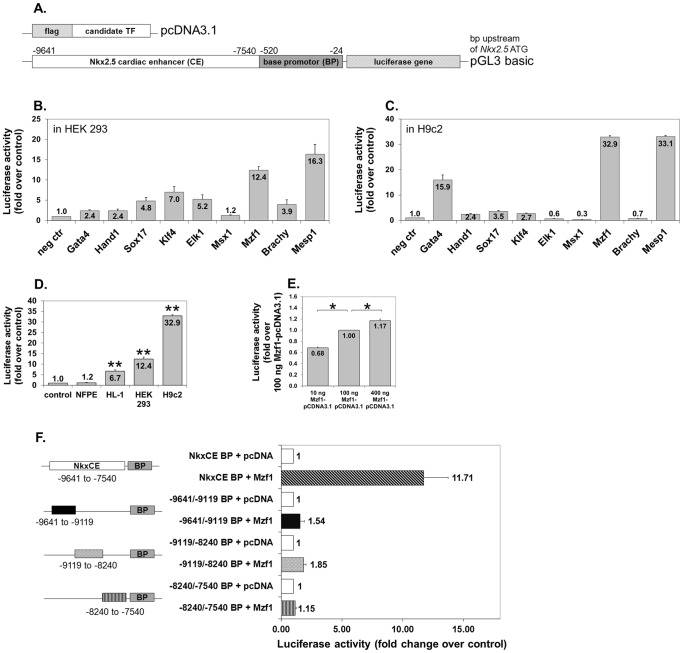
TF screening on the Nkx2.5 CE element by luciferase reporter assays.
A. Plasmid constructs for luciferase reporter assays. The empty modified pcDNA3.1 was used as a negative control in all assays. B. TF screening by luciferase assays using HEK 293 cells (human embryonic kidney fibroblasts). Fold change is compared to the negative control (neg ctr) (pcDNA3.1). C. TF screening by luciferase assays using H9c2 cells (rat myoblasts). Fold change is compared to the negative control (neg ctr) (pcDNA3.1). D.
Mzf1 activates the Nkx2.5 CE element in atrial HL-1 cells but not in endothelial NFPE cells. Asterisks indicate a significant difference compared to the control (pcDNA3.1); **  =  p <0.01. E. Dose dependent effect of Mzf1-pcDNA3.1-DNA on Nkx2.5 CE activation in HEK 293 cells; *  =  p <0.05. F. Effect of truncating different parts of the Nkx2.5 CE according to Lien and co-workers [7] on luciferase activation by Mzf1 in HEK 293 cells.